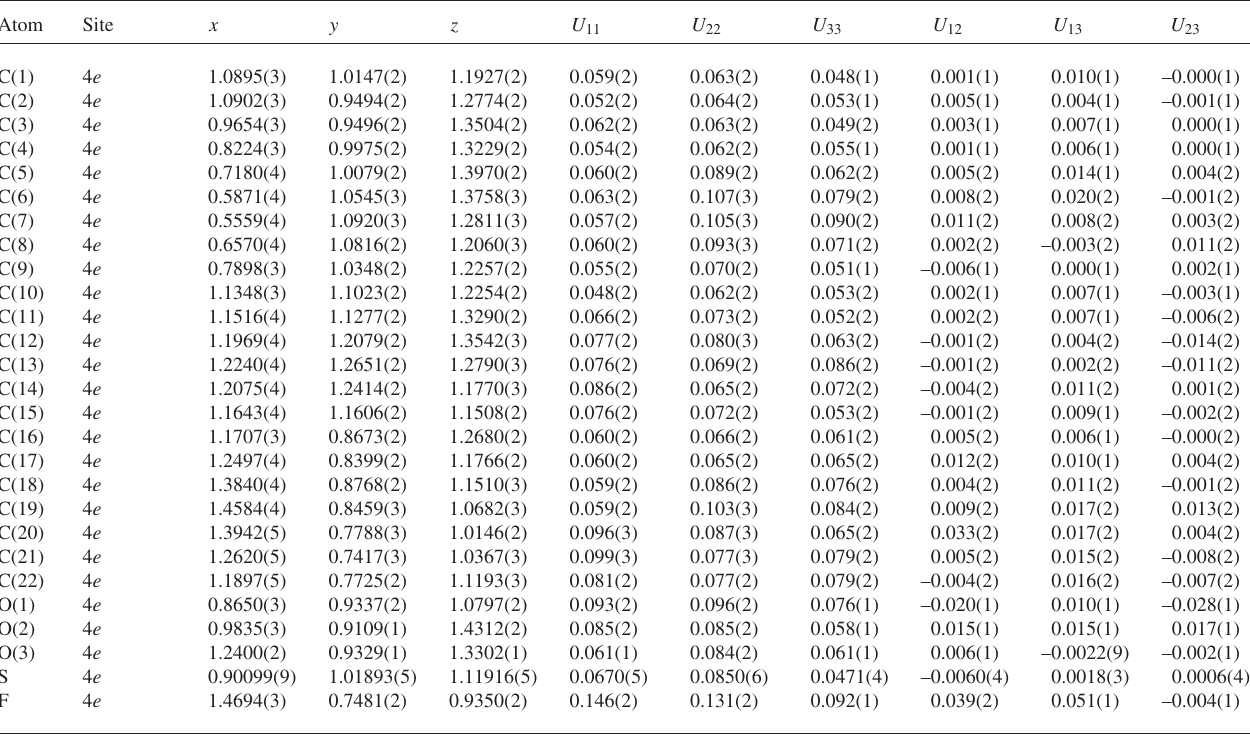
Table 3. Atomic coordinates and displacement parameters (in Å 2 )